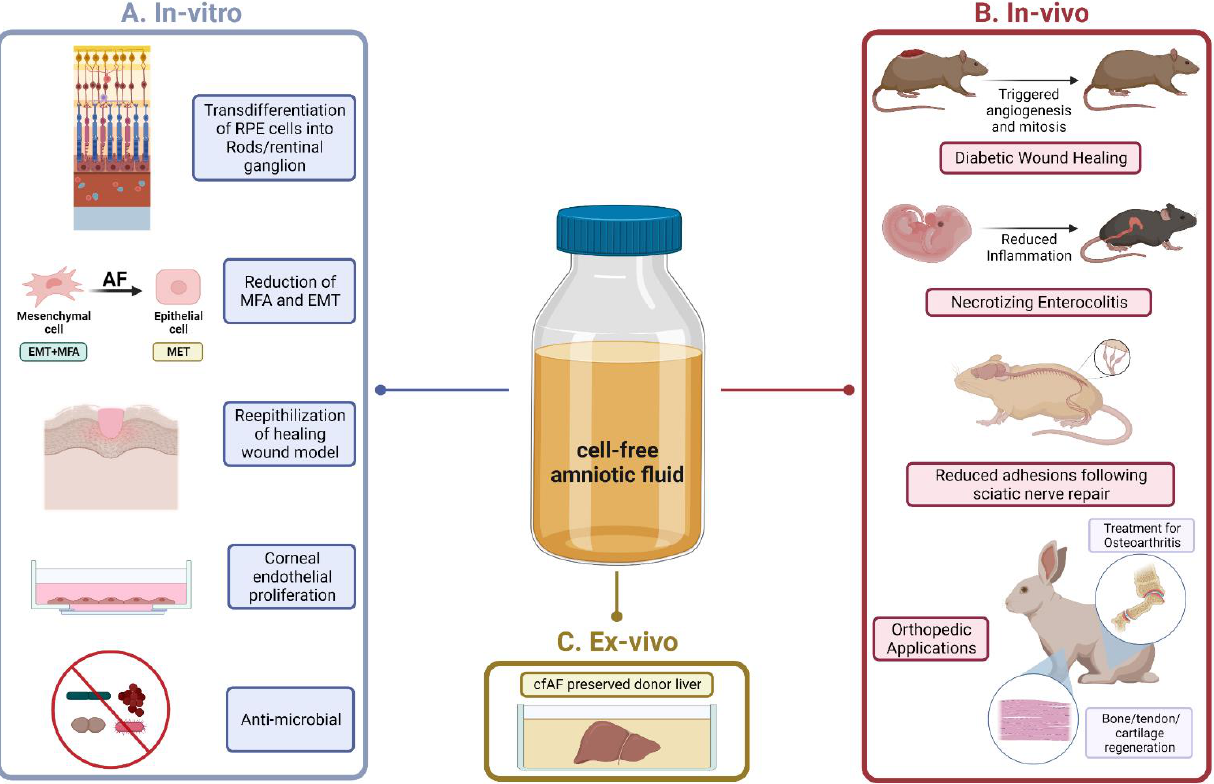
Figure 3. Summary of Translational Studies using Cell-Free Amniotic Fluid. ( A ). The in vitro studies (left panel) highlight fundamental studies that have added significant depth and understanding to the mechanistic underpinnings of how the therapeutic effects of cfAF are mediated in target cells/tissues. ( B ). The in vivo studies (right panel) highlight several animal models that have been used in cfAF research. Notable studies include rodent models of (from top to bottom): diabetic chronic wound healing, necrotizing enterocolitis, and nerve regeneration; rabbit models for various orthopedic applications including osteoarthritis and musculoskeletal regeneration are shown at the bottom. ( C ). The ex-vivo study (bottom, middle panel) references the application of cfAF in liver organ-tissue preservation prior to transplantation. (Image created with Bio Render).